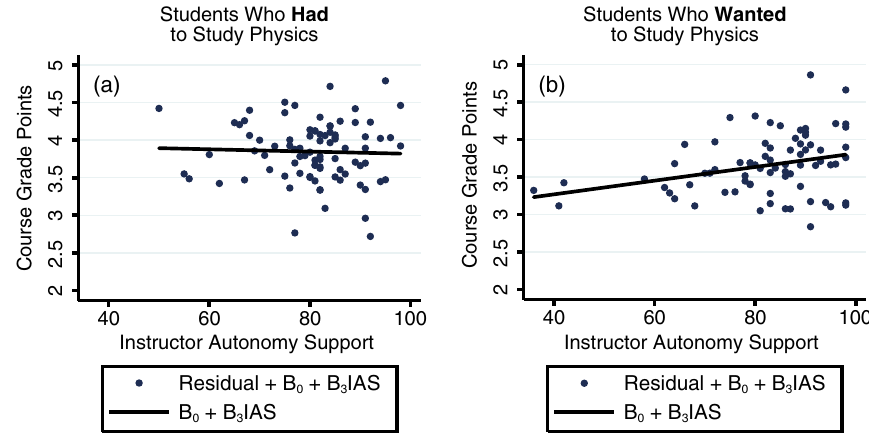
FIG. 3. Component-plus-residual plots for the two models of Table VI that were for (a) the subset of students initially taking physics more because they had to [i.e., for relatively less autonomous reasons or RAI ð T 1 Þ < 0 ] and for (b) the subset initially taking physics more because they wanted to [i.e., for relatively more autonomous reasons or RAI ð T 1 Þ > 0 ]. The slope of the line in each plot is B 3 , the best-fit coefficient of IAS from the multiple regression, and thus shows the dependence of Course Grade on IAS after controlling for incoming GPA, gender, and differences among instructors in student performance. It is also the best linear fit to the data points, which are the residuals of the full model plus the B 0 and B 3 IAS components of the model. These plots show the significantly different correlation of Instructor Autonomy Support with performance depending on students ’ initial relative autonomous reasons for studying physics. IAS was positively correlated with performance, only for students initially studying physics for relatively autonomous reasons.